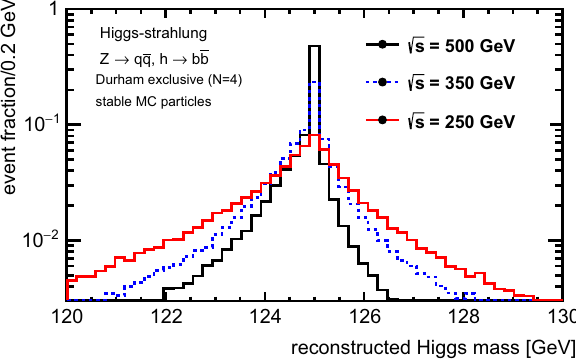
Fig. 1 The reconstructed Higgs boson mass peak in e + e − → Zh , Z → q ¯ q , h → b ¯ b events. The three histograms correspond to centre- of-mass energies of 250 GeV (red, continuous line), 350 GeV (blue, dashed line) and 500 GeV (black, continuous line) ¯ b decays and subse- age and the Z → q ¯ q and h → b quent hadronisation with Pythia8 [24]. The Higgs boson mass in the simulation is 125 GeV. No beam energy spread, initial-state radiation, or modelling of background or the detector are included. Stable particles are clustered into jets with the Durham algorithm (exclusive clustering with N =